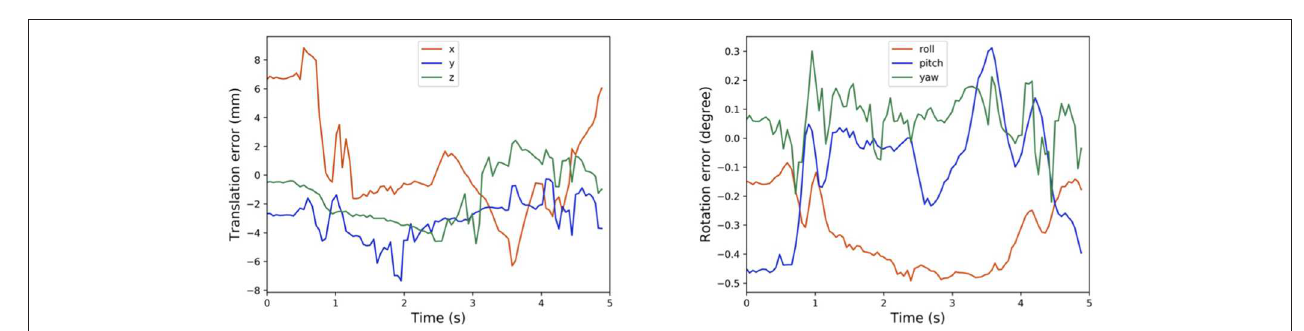
FIGURE 7 | Tracking calibration error using the first wrist